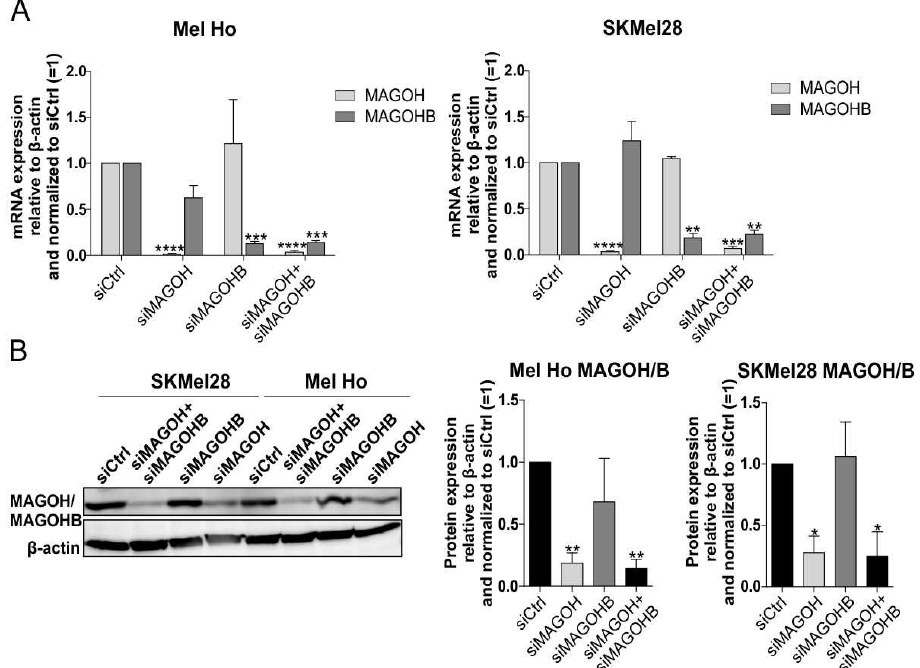
Figure 2. SiRNA-mediated knockdown of MAGOH and MAGOHB expression in the cutaneous melanoma cell lines Mel Ho and SKMel28. ( A ) Relative MAGOH and MAGOHB mRNA expression compared to β-actin(ΔCP), measured with qRT-PCR, after 24 h (Mel Ho) or 48 h (SKMel28) of transfection with siRNAs targeting MAGOH, MAGOHB or both, normalized to a control siRNA (mean ± SD of n = 3, ** = p < 0.01, *** = p < 0.001, **** = p < 0.0001, one sample t -test compared to 1). ( B ) Western blot analysis of MAGOH/MAGOHB protein expression after 48 h transfection of Mel Ho and SKMel28 with siRNAs targeting MAGOH, MAGOHB or both, compared to a control siRNA. Bar graphs show the quantification of MAGOH/MAGOHB protein levels compared to β-actin (mean ± SD from n = 3, * = p < 0.05, ** = p < 0.01, one sample t -test compared to 1).